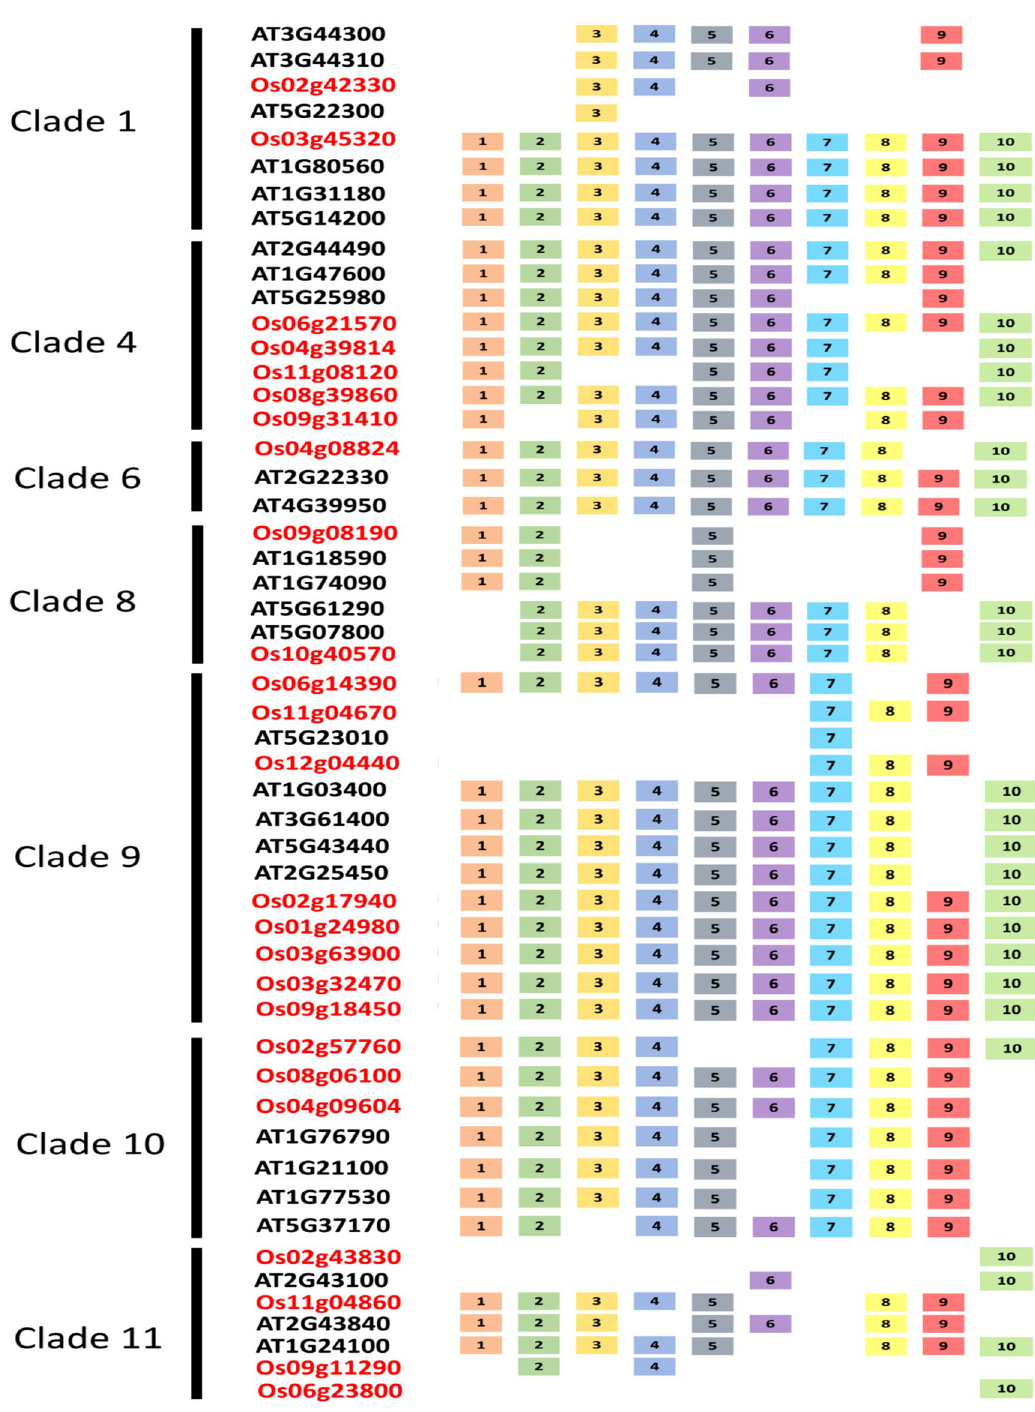
Figure 3. Motif distribution structure of Arabidopsis thaliana and Oryza sativa sulfur-encoding biosynthetic genes grouped by clades. The A. thaliana (ATXXXXXXX) and O. sativa (OsXXXXXXXX) gene IDs are written in black and red, respectively. Detailed information on the motif sequence information and annotation is available in Supplementary